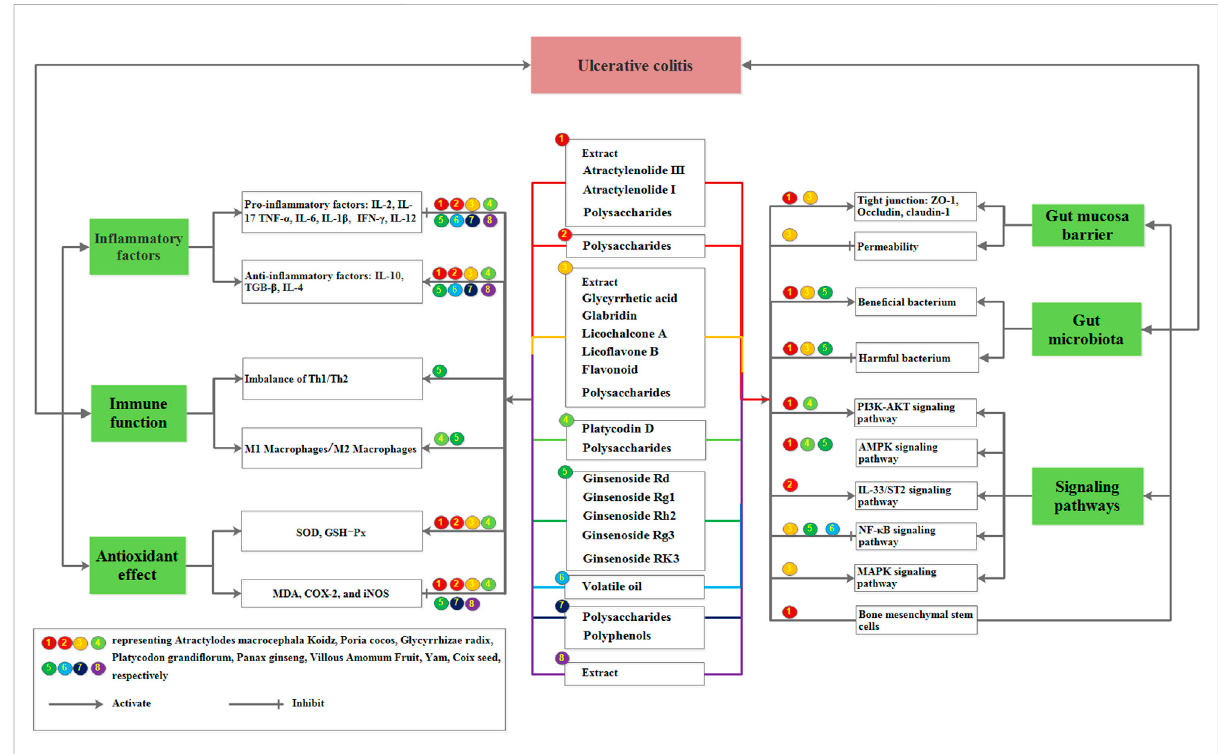
FIGURE 6 Effects of single Chinese herb and its active ingredients from SLBZP in treatment of